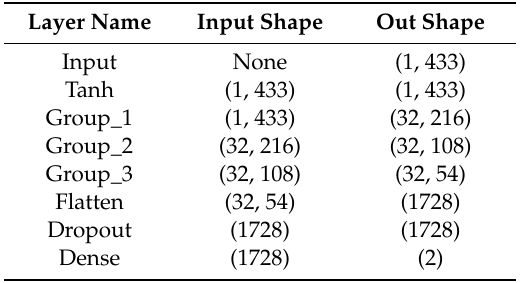
Table 4. The dimensional change of the input data in the proposed